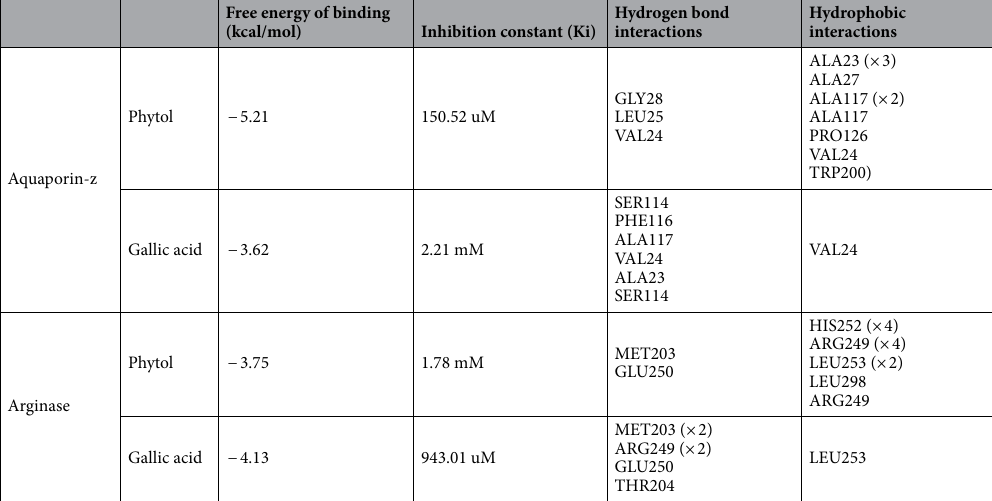
Table 2. Binding affinities and potential molecular interactions of gallic acid and phytol with aquaporin-z and